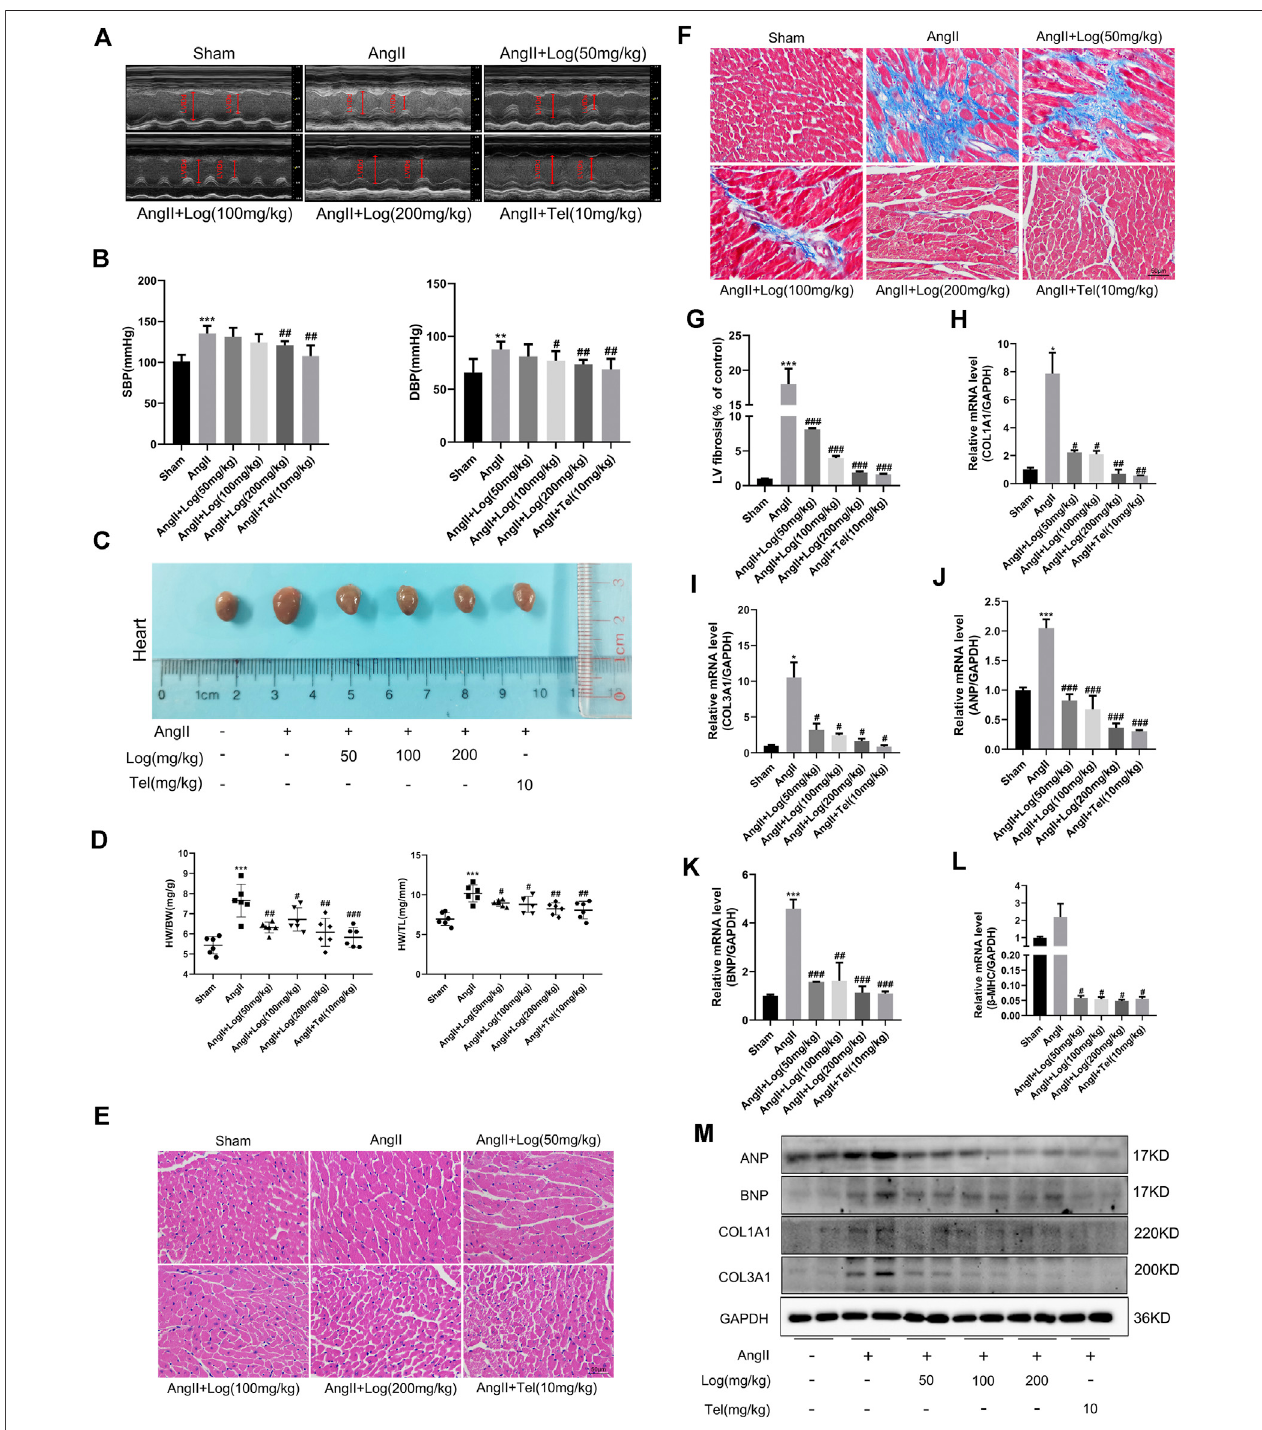
FIGURE 2 | Loganin suppresses cardiac hypertrophy and fi brosis induced by Ang II in vivo. (A) Representative echocardiography pictures. Echocardiography M-mode imaging obtained from C57BL/6 mice with or/and without Ang II and loganin treatment. M-mode images obtained from short-axis measurements are used to assesscardiacfunction.Verticalarrowsrepresentthediametersoftheleftventricleatenddiastolicorsystolicstages. (B) Statisticalresultsforthesystolicbloodpressure (SBP) and diastolic blood pressure (DBP). (C) Morphological images of mouse hearts are obtained from the sham, Ang II, Ang II + Log (50 mg/kg), Ang II + Log (100 mg/kg), Ang II + Log (200 mg/kg), and Ang II + Tel (10 mg/kg) groups. (D) Ratio of heart weight (HW) to body weight (BW) and ratio of HW to tibia length in each group. (E) Paraf fi nsectionsofcardiactissuesarestainedwithH&E.Representativeimagesareshown.Scalebar:50 μ m. (F) Masson ’ strichromestainingofhypertrophic